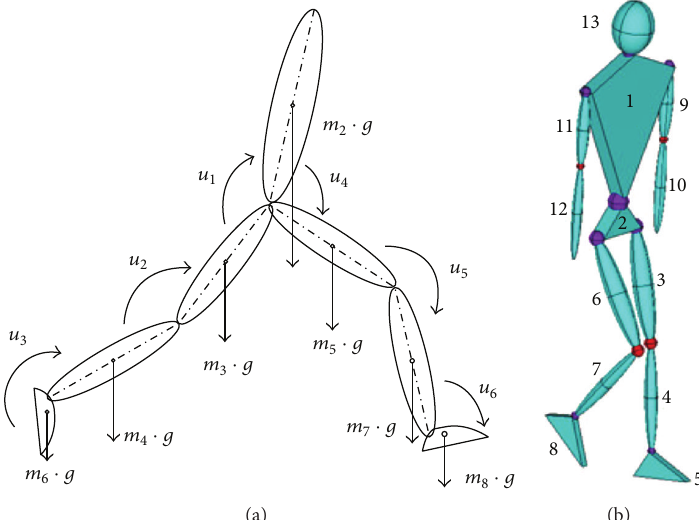
Figure 13: The 2D walking human model, comprising 8 bodies and 9 DOFs (a) and the 3D walking human model, with 13 rigid bodies and 34 DOFs